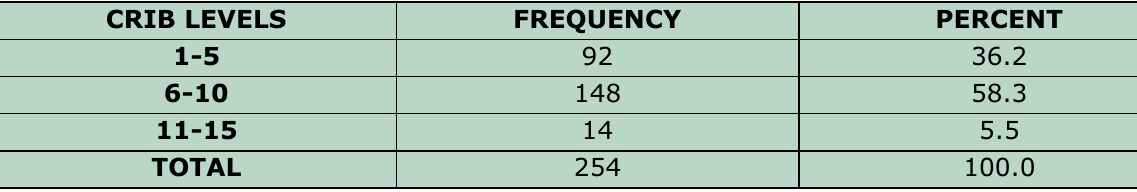
Table-II: C  RIB-score levels study in population.